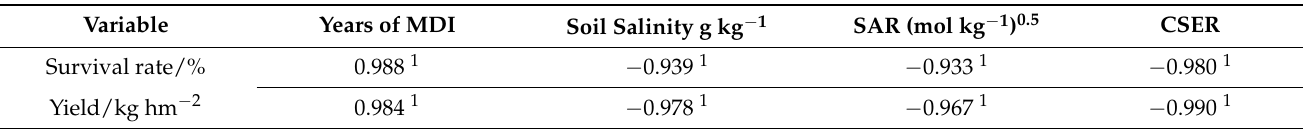
Table 4. Dependence analysis results of cotton survival rate and yield of cotton on the years of MDI, soil salt content, SAR and CSER,